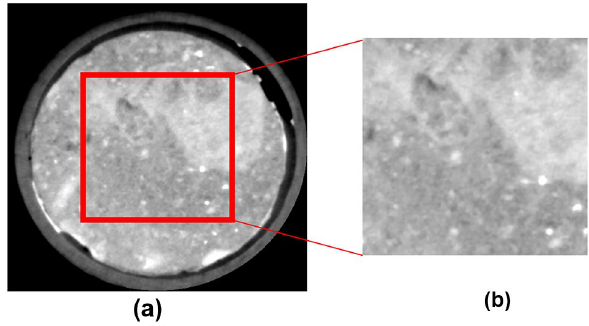
Fig. 2 Original DICOM image slices a are cropped (red square) into 256x256 squares b as a preprocessing step to prepare images to be used as inputs for the CNN training process